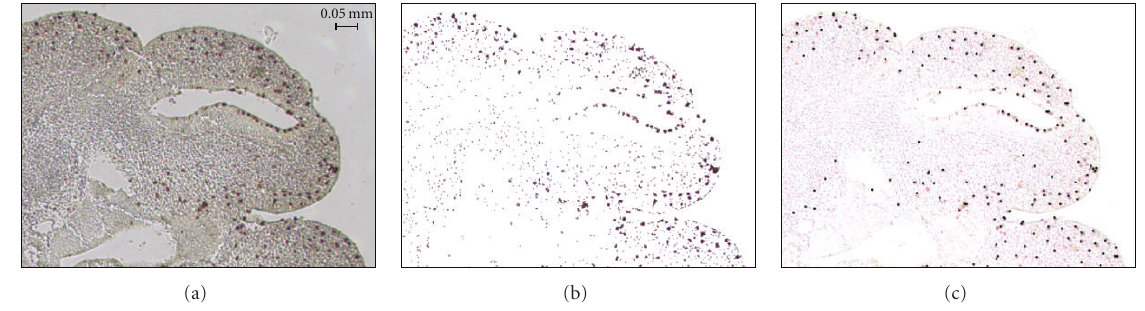
Figure 5: The use of color filtering for estimating cell locations. (a) Details of a portion of the original tissue sample shown in Figure 1(b). (b) The same region after color filtering. (c) The cell locations shown as black